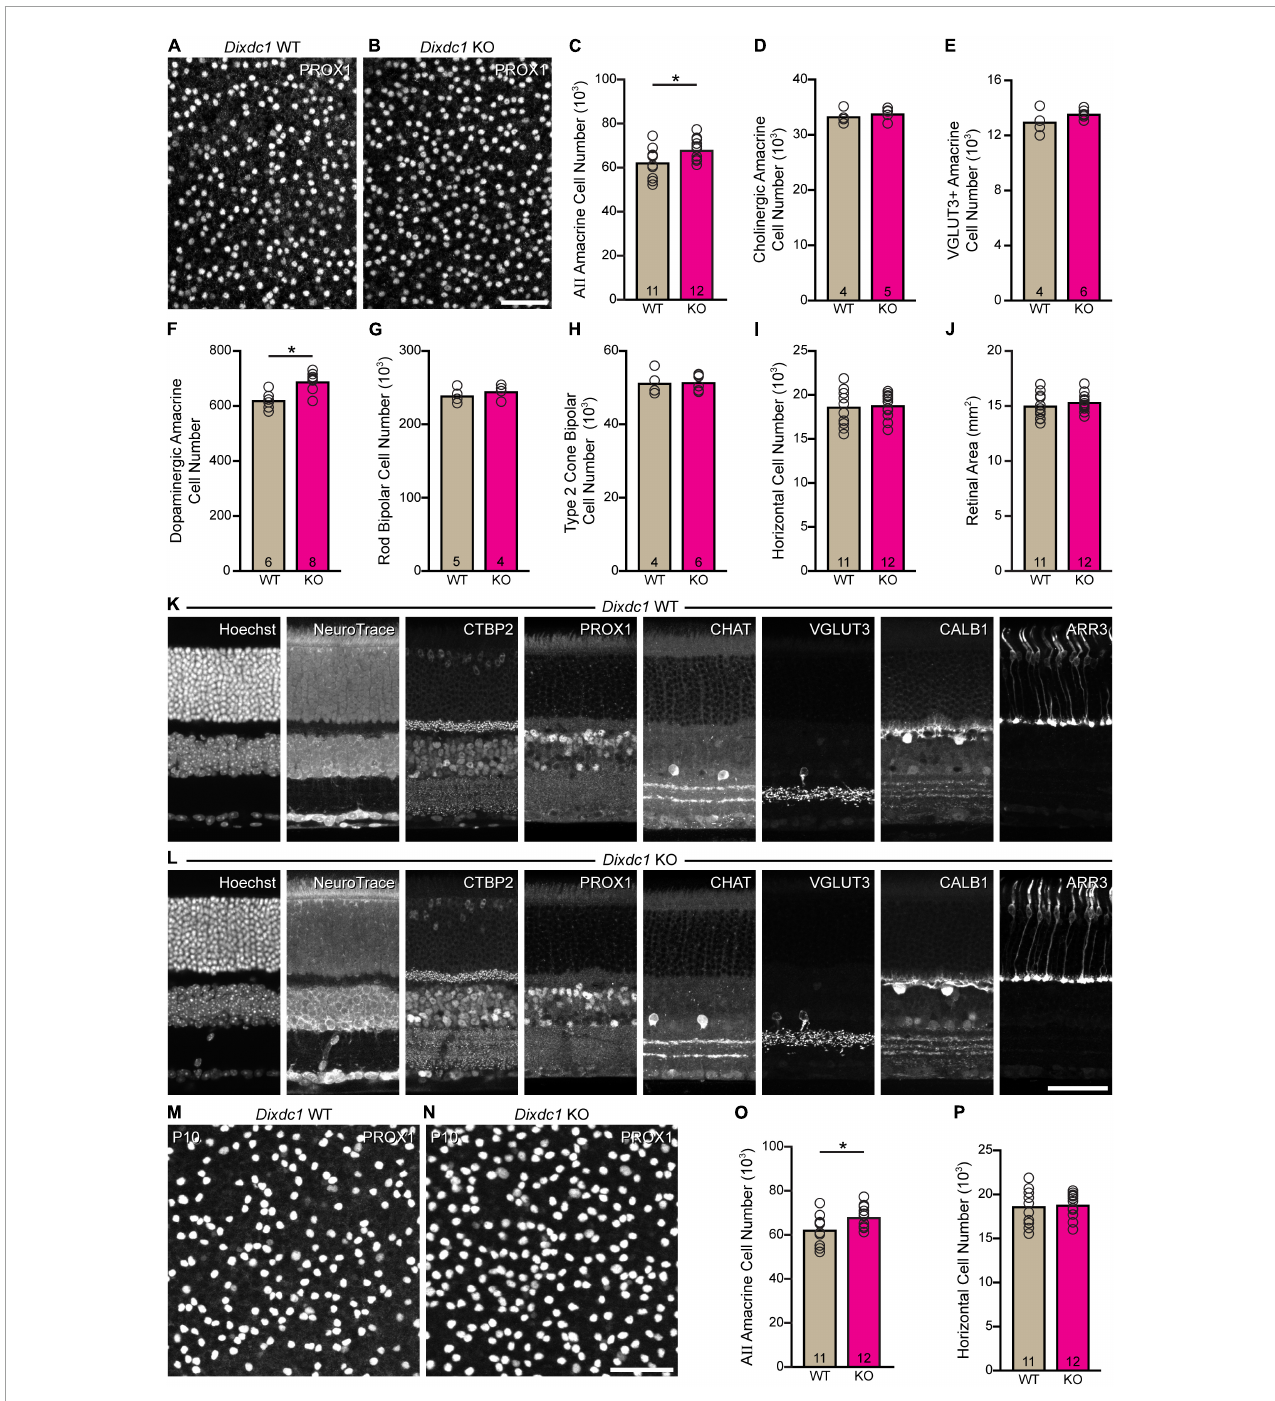
FIGURE6 Loss of Dixdc1 increases AII amacrine cell number. (A–C) Dixdc1 KO retinas have a significant increase in the size of their AII amacrine cell population, by about 10%. (D–I) Of six other sampled retinal populations, only the dopaminergic amacrine cells were significantly different, showing a comparable increase in size. (J) The areal size of the retina was unaltered in Dixdc1 KO mice. (K,L) Both the cellular and synaptic architecture of the retina were unaffected. (M–P) A replication at P10 confirmed a comparable effect upon AII amacrine cell number, while finding no difference in horizontal cell number. n = the number of retinas sampled in panels (C–J,O,P) . Calibration bar in panels (A,B,K–N) = 50 µ